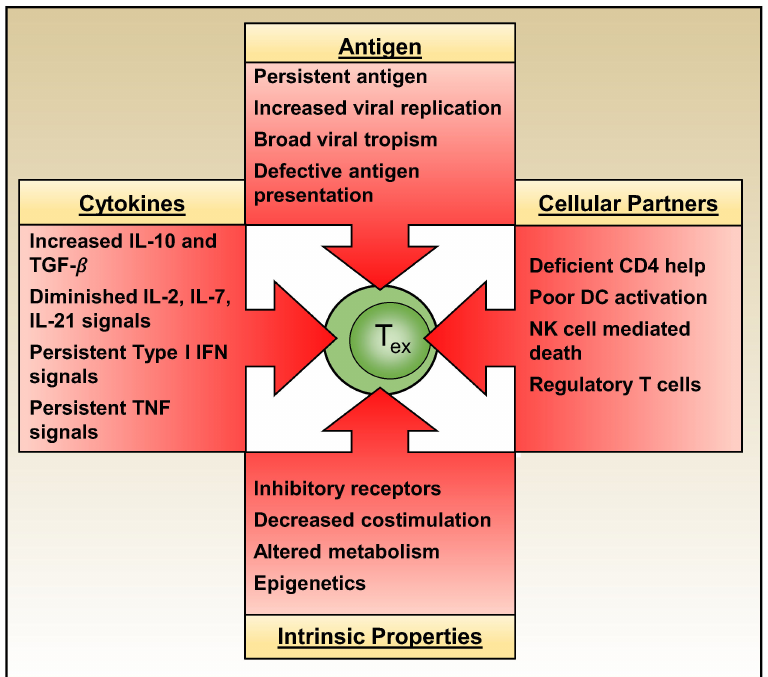
Figure 5. CD8 T cell exhaustion is regulated by the integrated actions of both extrinsic and intrinsic factors. Antigen availability and the cytokine milieu, together with other cellular partners all influence the development and maintenance of exhaustion. Exhausted T cells also self-regulate by their expression of inhibitory receptors and costimulatory molecules, as well as through their metabolic state and epigenetic